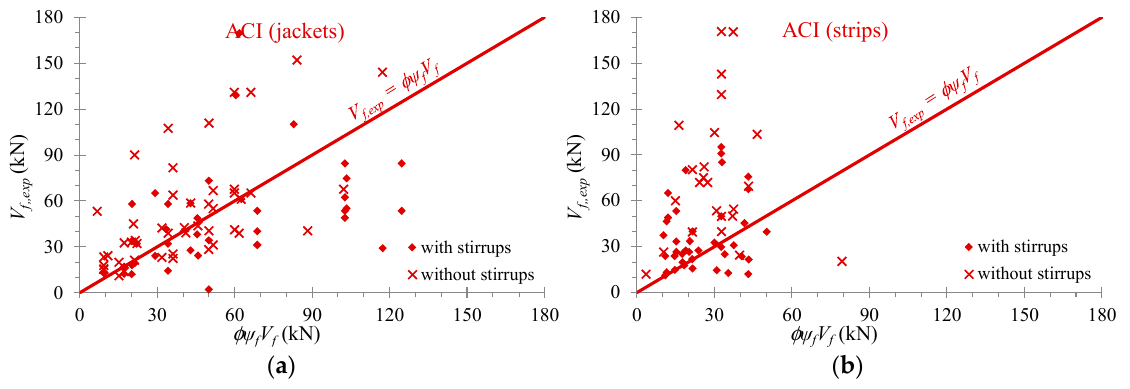
Figure 8. Results obtained based on the provisions of the ACI Committee 440: ( a ) U-shaped retrofitted T-beams with EB-FRP jackets; ( b ) U-shaped retrofitted T-beams with EB-FRP strips.